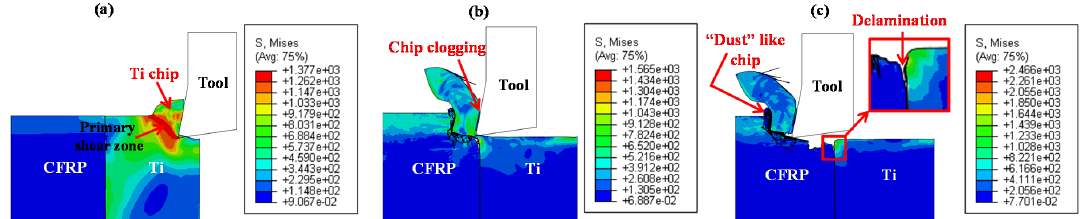
Figure 7. Chip ‐ morphology evolution during CFRP/Ti cutting: ( a ) Ti ‐ phase cutting; ( b ) interface cutting; ( c ) CFRP ‐ phase cutting ( v c = 40 m/min, f = 0.2 mm/rev and θ = 0°) (Note: the symbol “S” in the figure represents the von Mises stress and the unit is MPa).